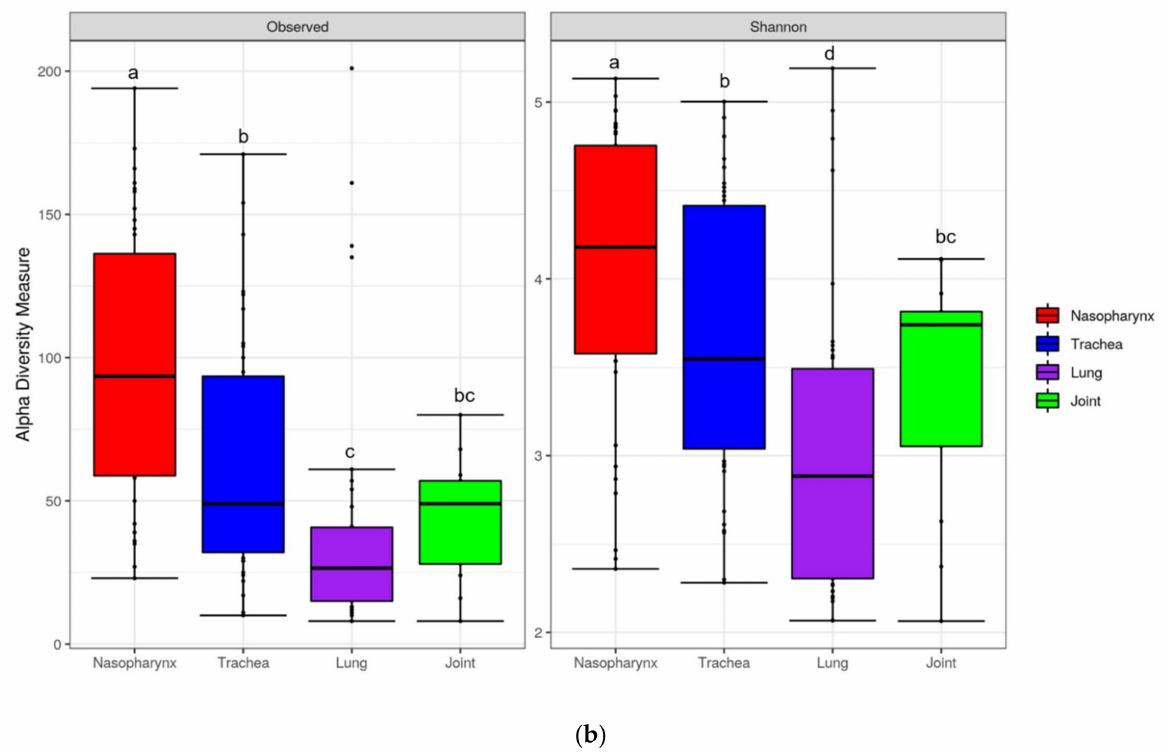
Figure 1. ( a ) Comparative alpha-diversity (observed and Shannon) of OTUs in respiratory tract and joint microbiota from case and control cattle. Different lowercase letters associated with each sample type differ at p < 0.05. ( b ) Comparative alpha-diversity (observed and Shannon) of OTUs in respiratory tract and joint microbiota from BRD mortalities (cases). Different lowercase letters differ at p <